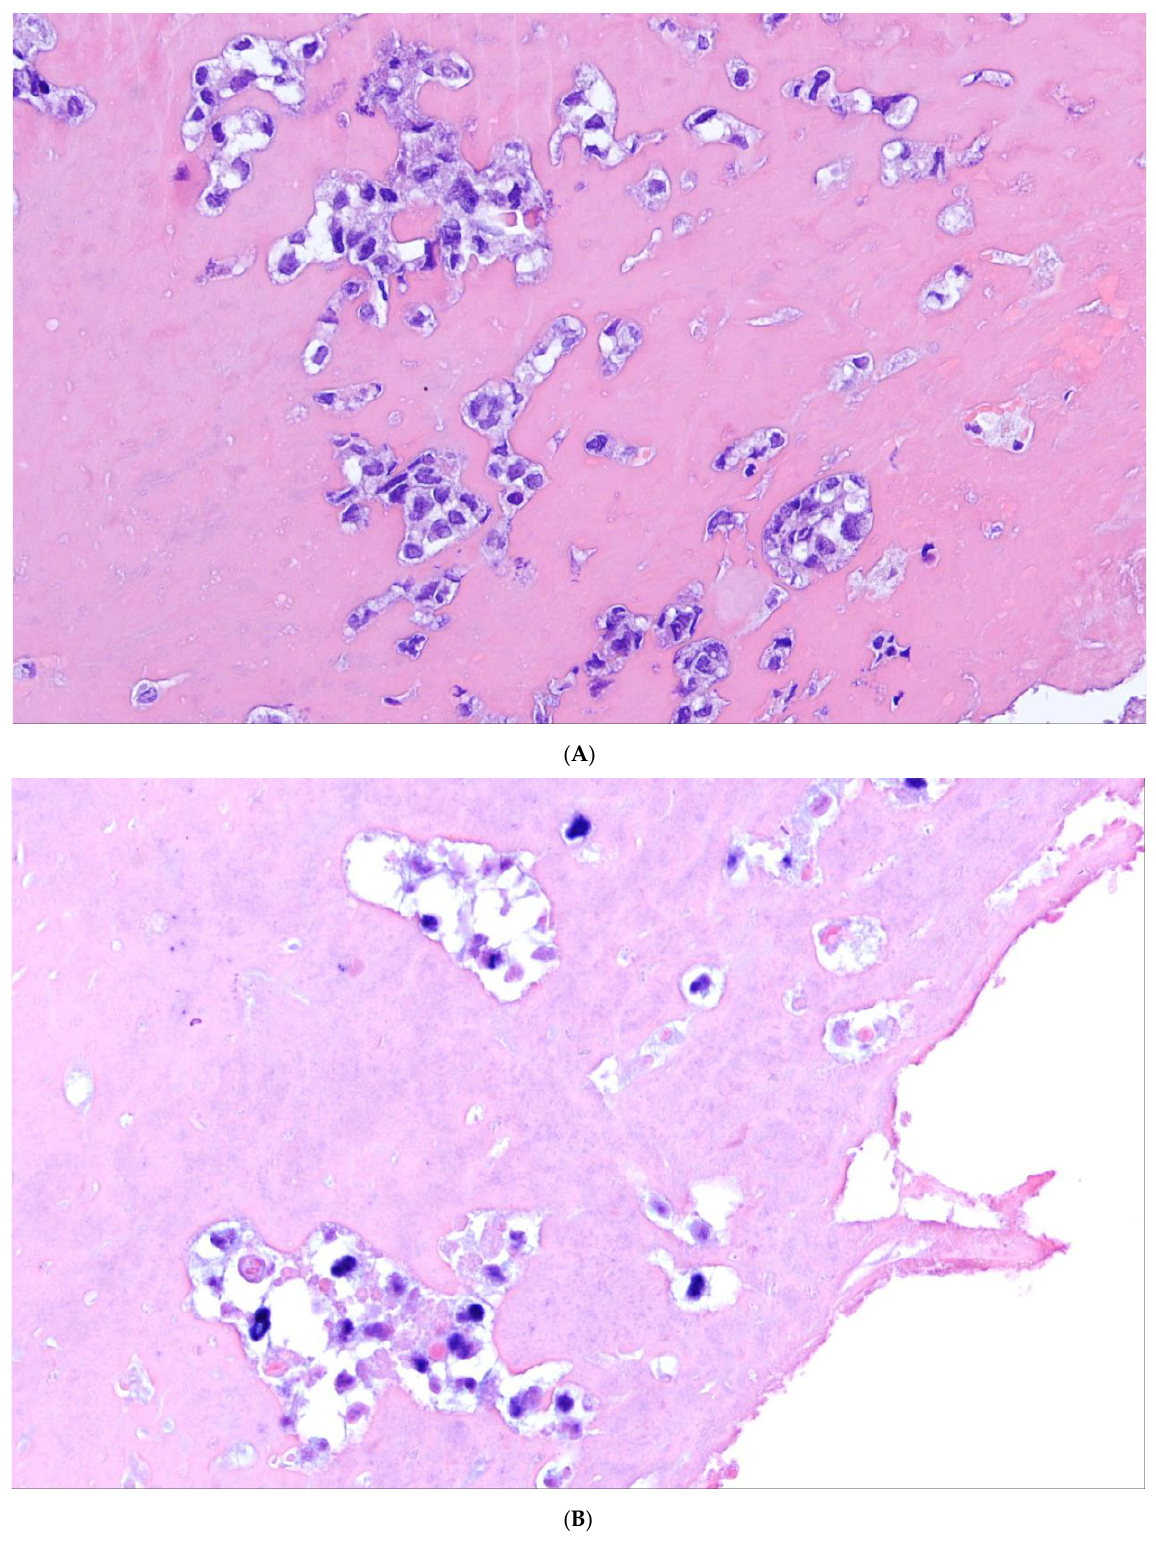
Figure 8. Fibrin-associated large B-cell lymphoma ( A ) (H&E ×200). Large transformed cells are float- ing in the background of fibrin and cellular debris. ( B ) (×200) EBER in situ hybridization confirmed floating in the background of fibrin and cellular debris. ( B ) ( × 200) EBER in situ hybridization EBV association. confirmed EBV